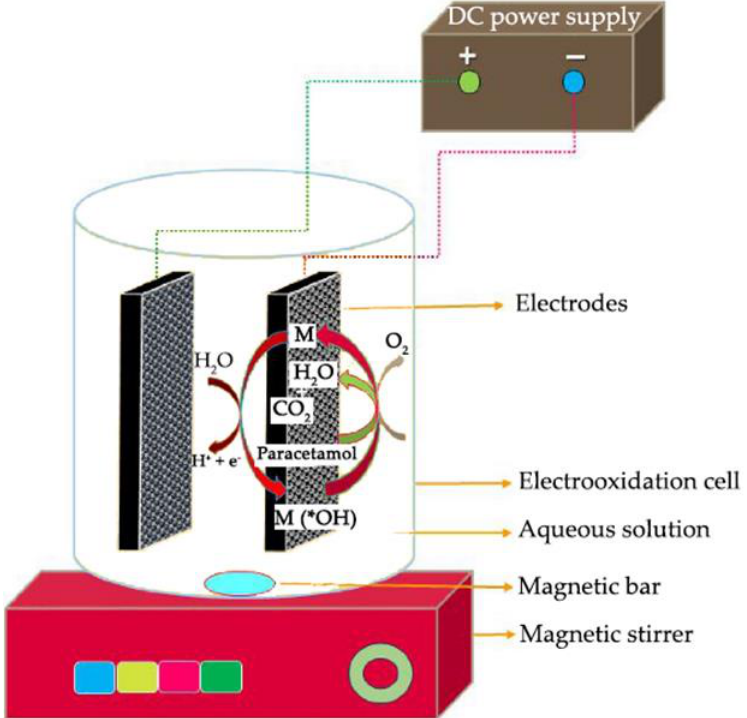
Figure 2. Diagram of the electrochemical reactor, using a glass beaker. The solution was stirred continuously throughout the process with a magnetic bar on a magnetic stirrer. The graphite anode was used as a working anode and a distance of 2 mm. Reprinted from Periyasamy and Muthuchamy [47], copyright © (2018) with permission from Elsevier.